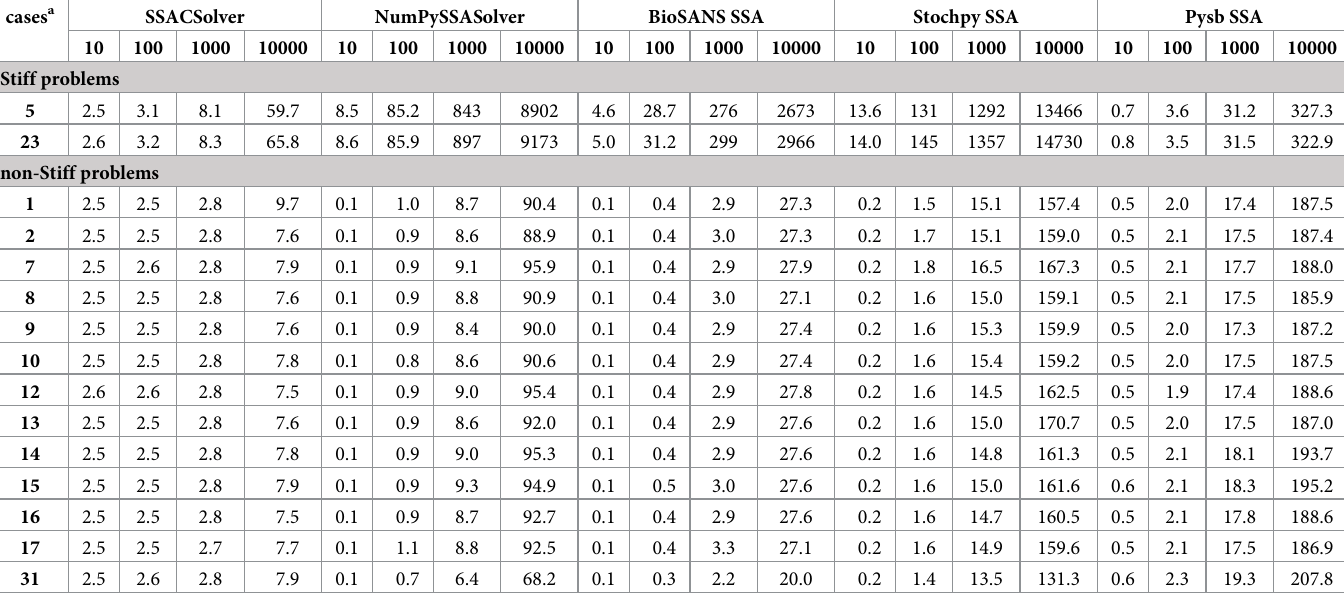
Table 4. Performance based on simulation time at 10, 100, 1000, and 10000